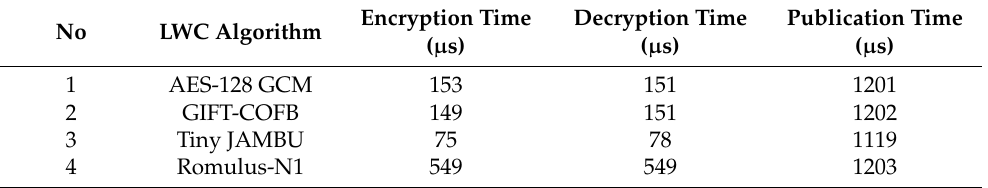
10 Characters Messages Used Anonymous Account.